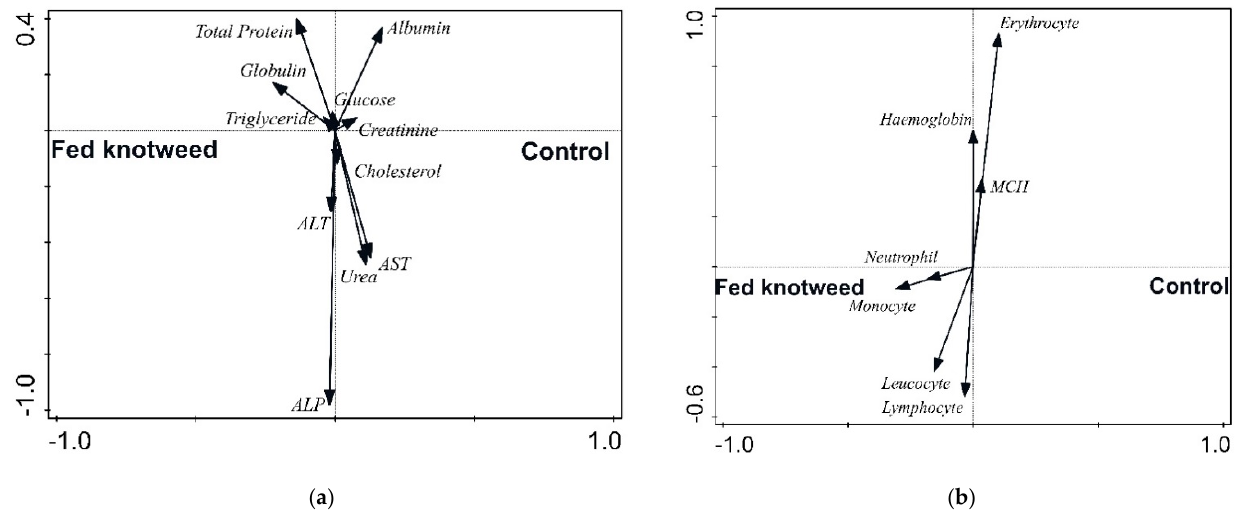
Figure 1. ( a ) Diagram showing the relationship of the biochemical data in Experiment 1. Treatment explained 1% of the variability in the biochemical data. Vectors pointing in the same direction show characteristics with positive correlations; arrows heading towards a type indicate that this type positively affects these characteristics. ( b ) Diagram showing the relatedness of the haematological data of Experiment 1. Treatment explained 1.5% of the variability in the haematological data. Vectors pointing in the same direction show characteristics with positive correlations; arrows heading towards a type indicate that this type positively affects these characteristics.